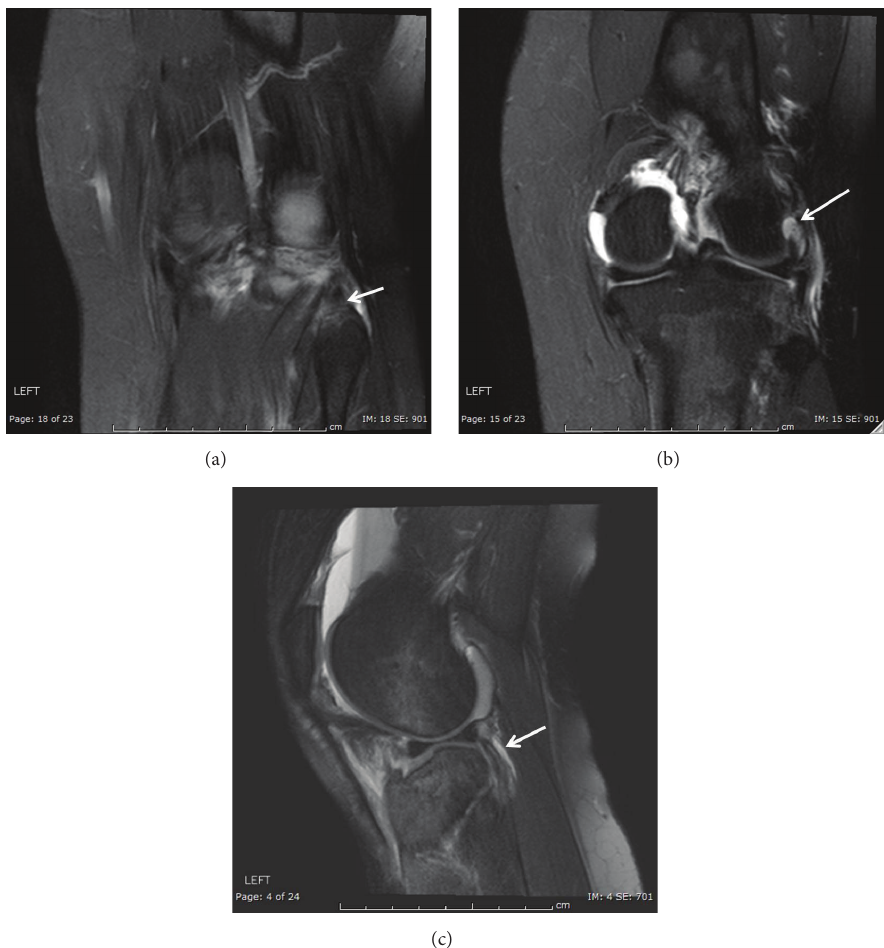
Figure 4: MRI of left knee showing popliteofibular ligament tear and edema in fibular styloid (arrow, (a)), attenuated LCL (arrow, (b)), and popliteus tendon signal abnormality suggesting interstitial tearing (arrow,